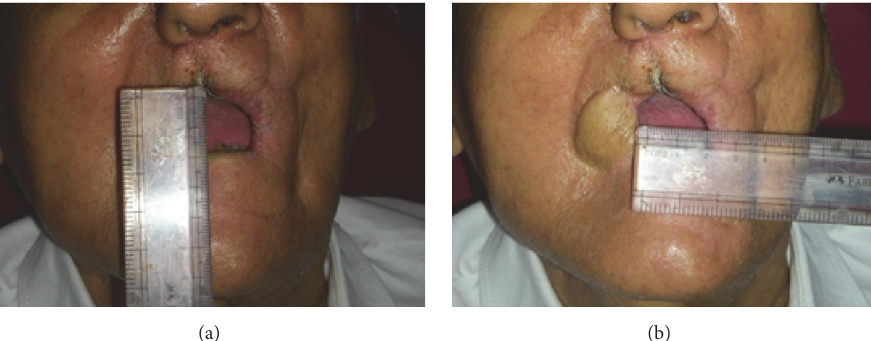
Figure 1: Extraoral view with maximum oral opening with (a) limited vertical length of oral aperture and (b) limited horizontal length of oral aperture.